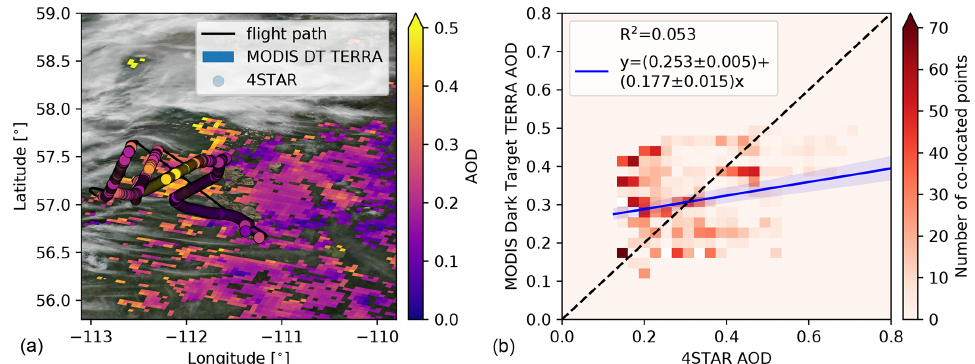
Figure 6. Comparison of AOD measured by 4STAR and retrieved by MODIS Dark Target (DT, MOD04_3K; Levy et al., 2015) for 9 June 2018. (a) The aerosol scene is overlaid on the true-colour imagery from MODIS TERRA, with the colour bar showing the AOD sampled by MODIS DT (in rectangular pixels) and 4STAR (circles put along the flight track of the NRC Convair-580). (b) The pixel-by-pixel comparison of the MODIS DT AOD and 4STAR AOD, with a best fit line in blue, and 95% confidence intervals of the fit line in blue shading. Table 1. FM AOD statistics for selected flights during the OSMC (mean ± SD). 4STAR in-plume and out-of-plume statistics are reported for the lowest flight level. Date (flight no.) 4STAR 4STAR 4STAR AERONET AERONET in-plume in-plume out-of-plume daily average daily max average maximum average 9 June (F14) 0 . 24 ± 0 . 08